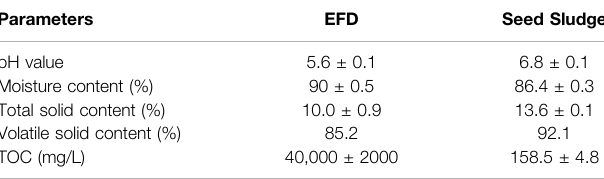
TABLE 1 | Basic physicochemical properties of the EFD and seed sludge in this study.